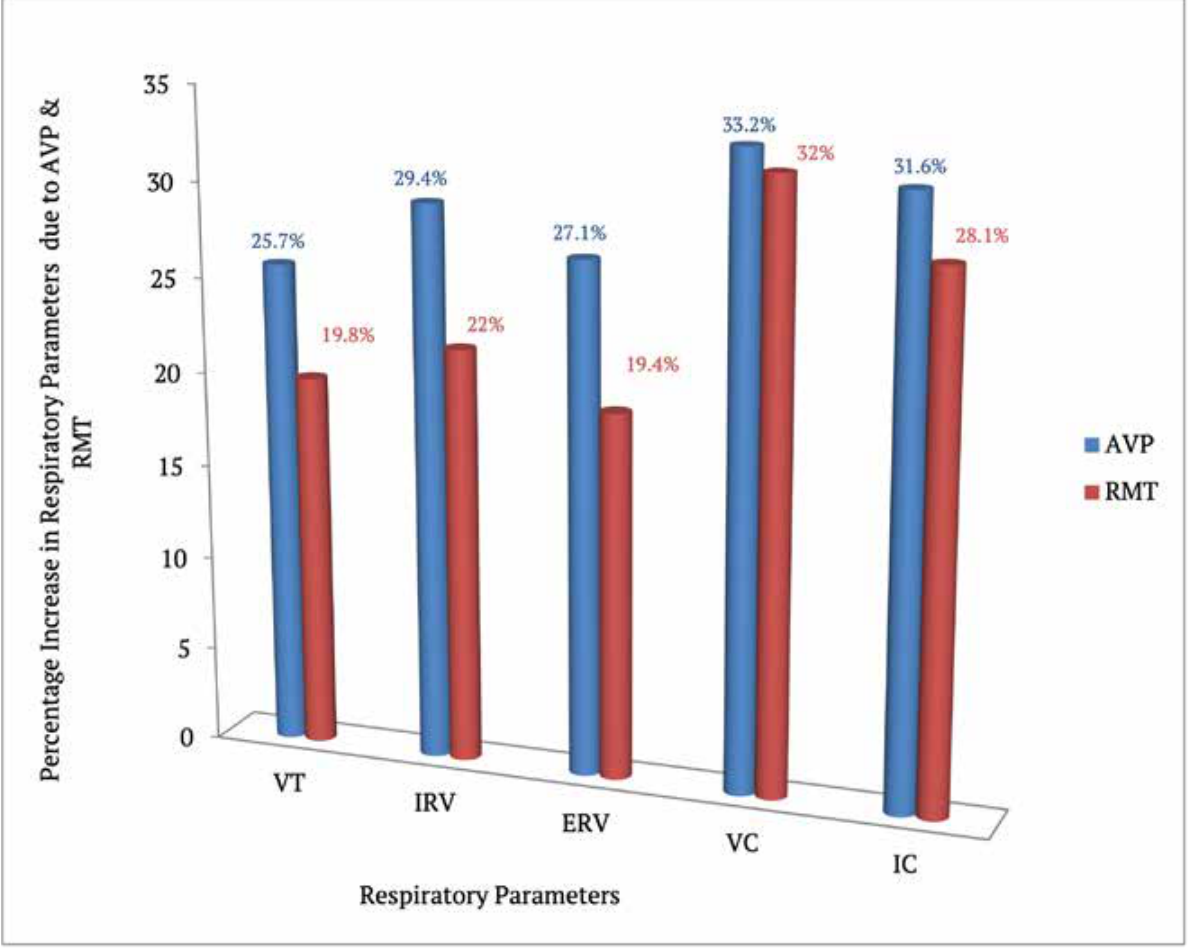
Figure 4. Comparison matrix between Group A verses Group C (VT=25.7%), (IRV=29.4%), (ERV=27.1%), (VC=33.2%) & (IC=31.6%) and Group B verses Group C (VT=19.8%), (IRV=22%), (ERV=19.4%), (VC=32%) & (IC=28.1%) of respiratory parameters including in